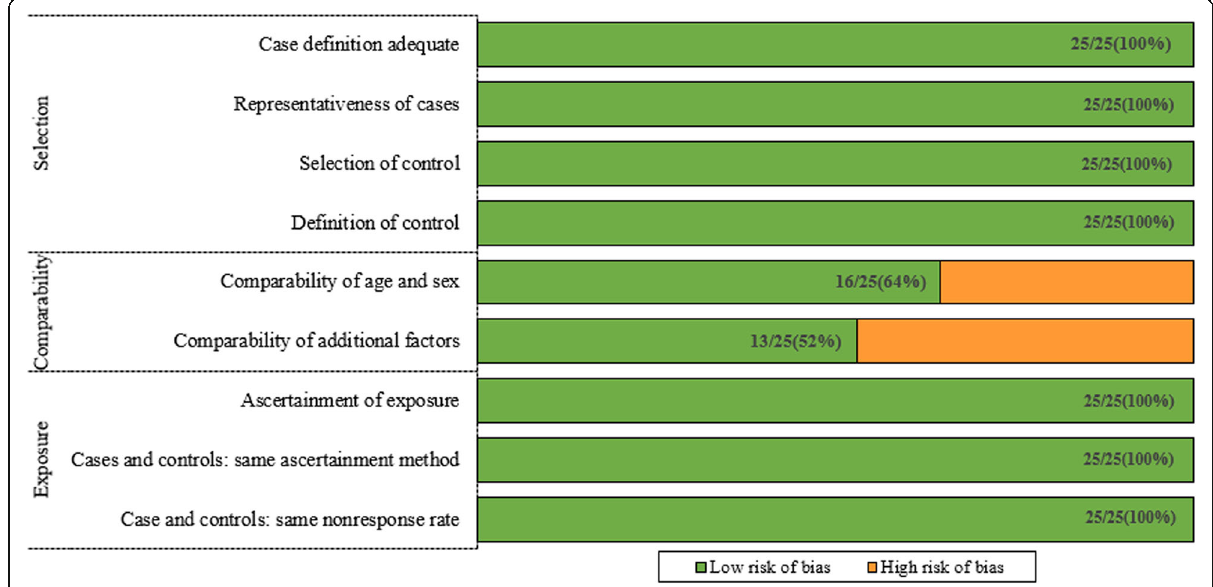
Fig. 2 Risk of bias by domain (in bold) and question in twenty-six case-control studies using the Newcastle – Ottawa